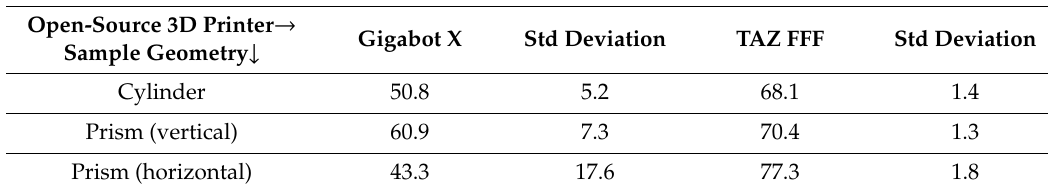
Table 2. Compression